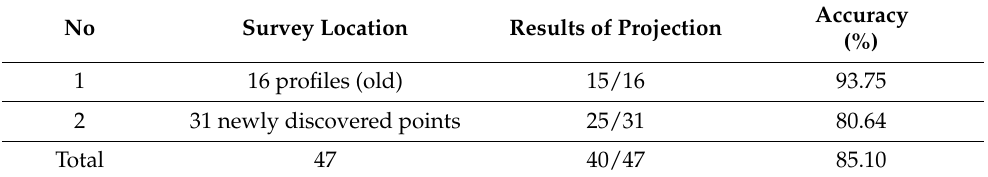
Table 8. Result of field